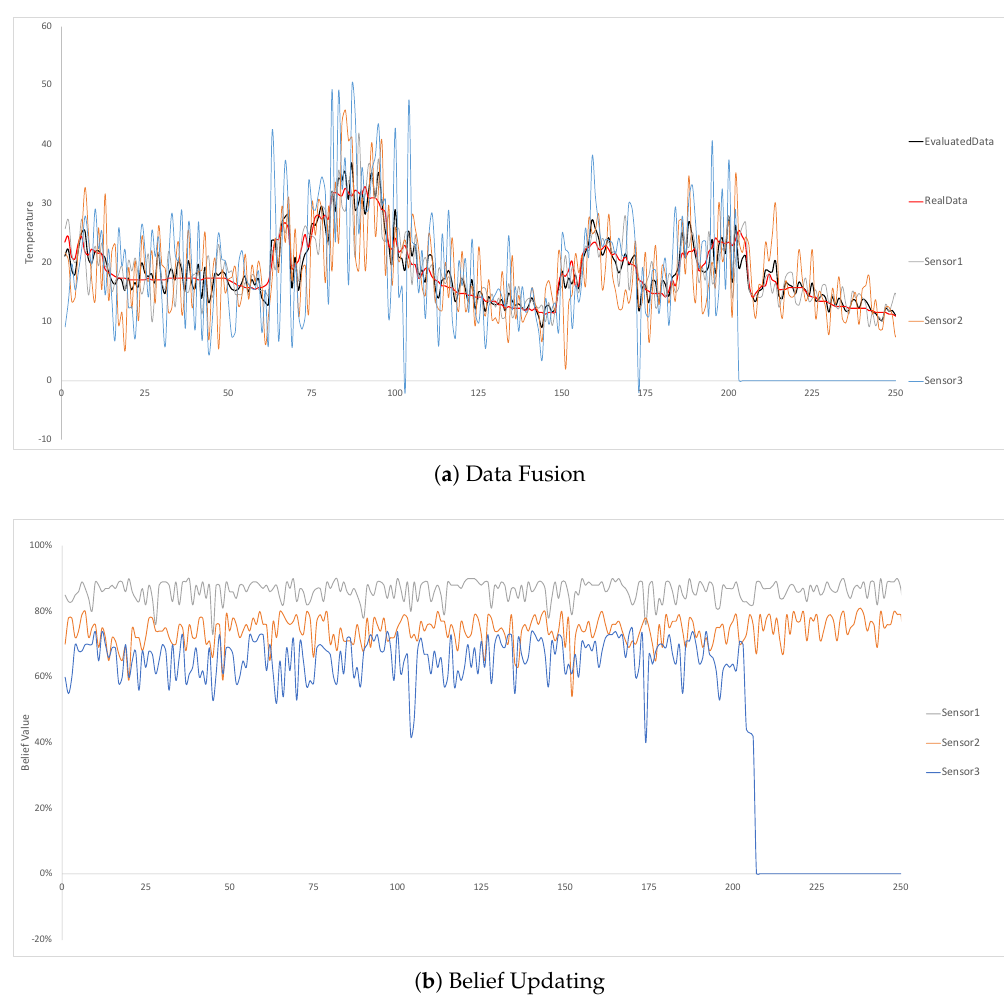
Figure 11. The permanent fault in sensor 3 is